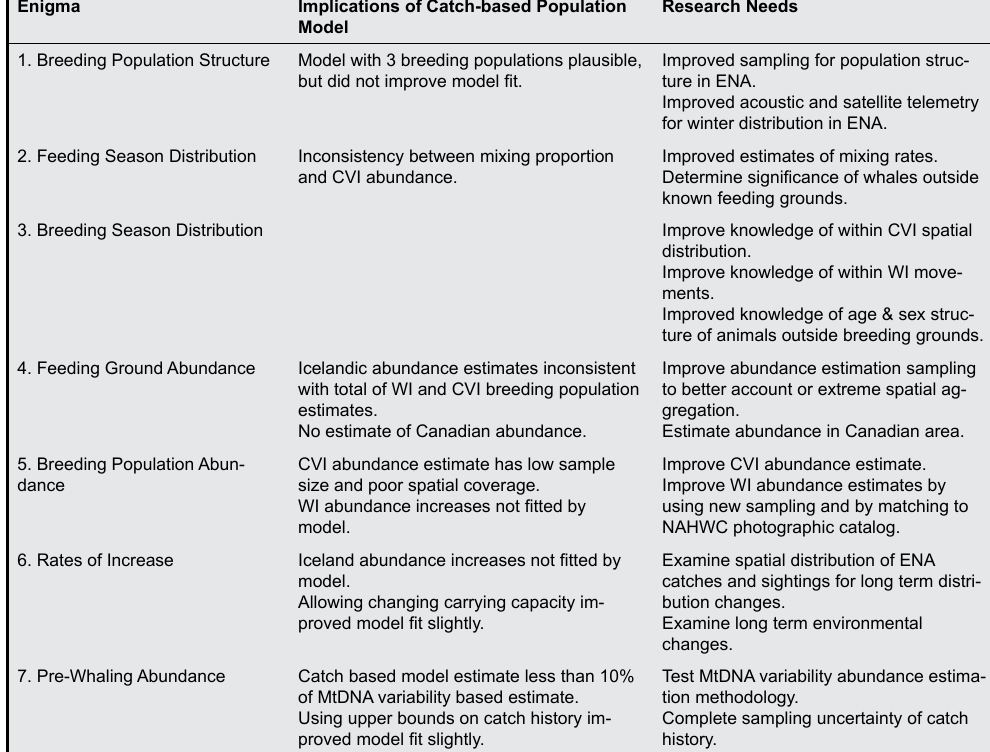
Table 4. Implications of the catch-based population model and needed research in terms of the 7 enigmas about North Atlantic humpback whales.